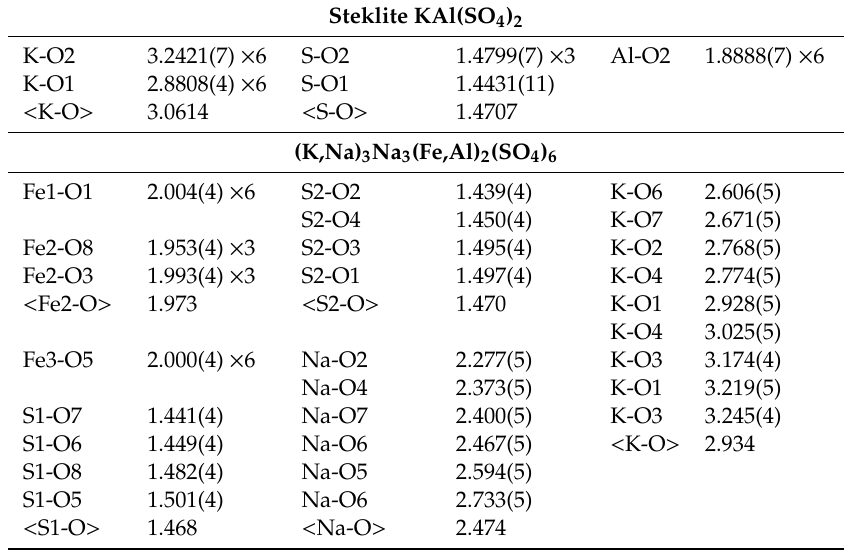
Table 4. Selected bond lengths (Å) in crystal structures of steklite and (K,Na) 3 Na 3 (Fe,Al) 2 (SO 4 ) 6